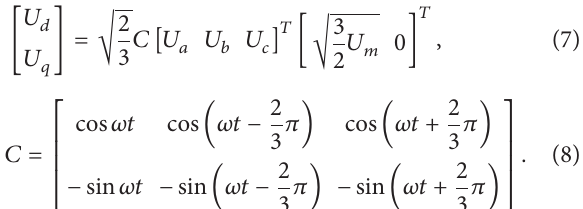
Figure 5: Simulation of power generation